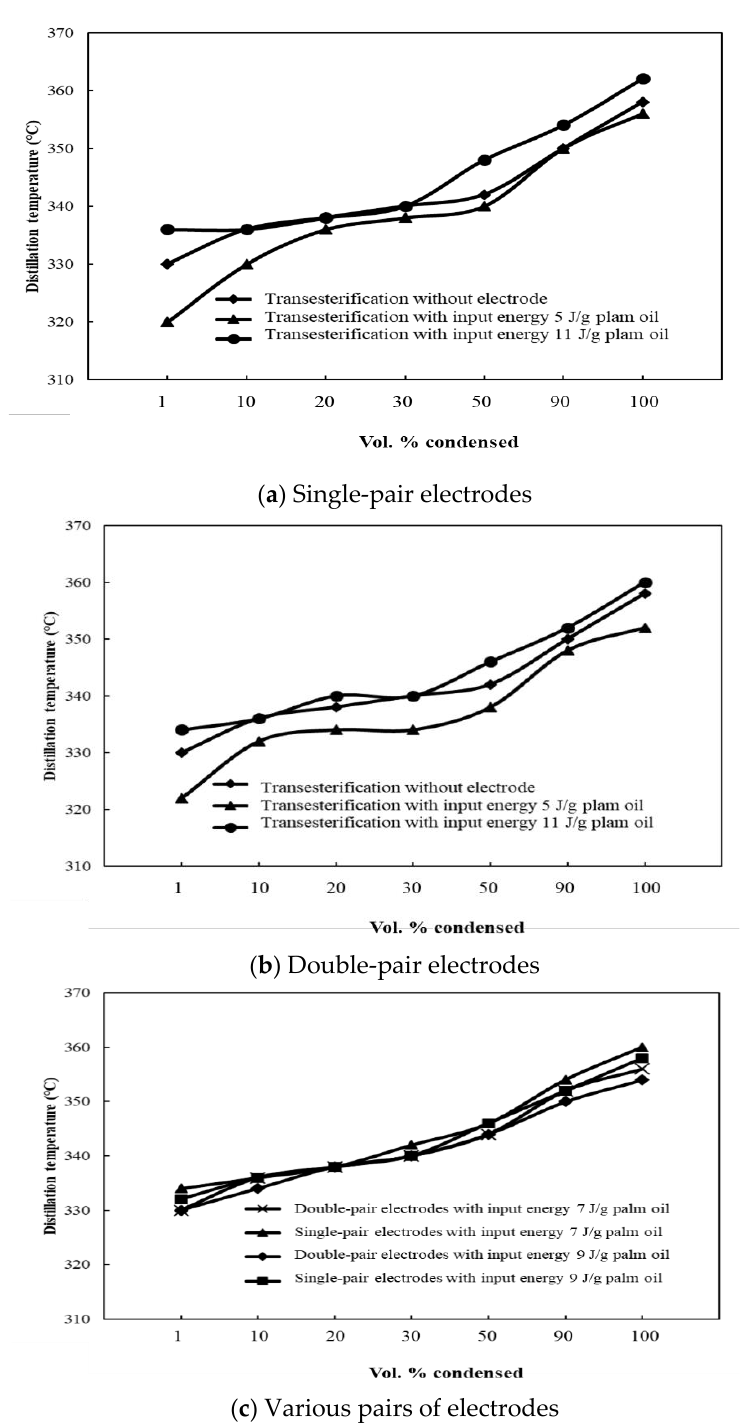
Figure 10. Effects of electrical energy input and number of electrodes for ( a ) single-pair, ( b ) double- pair, and ( c ) various pairs of electrodes for dissociating water on the distillation temperature of biodiesel product.